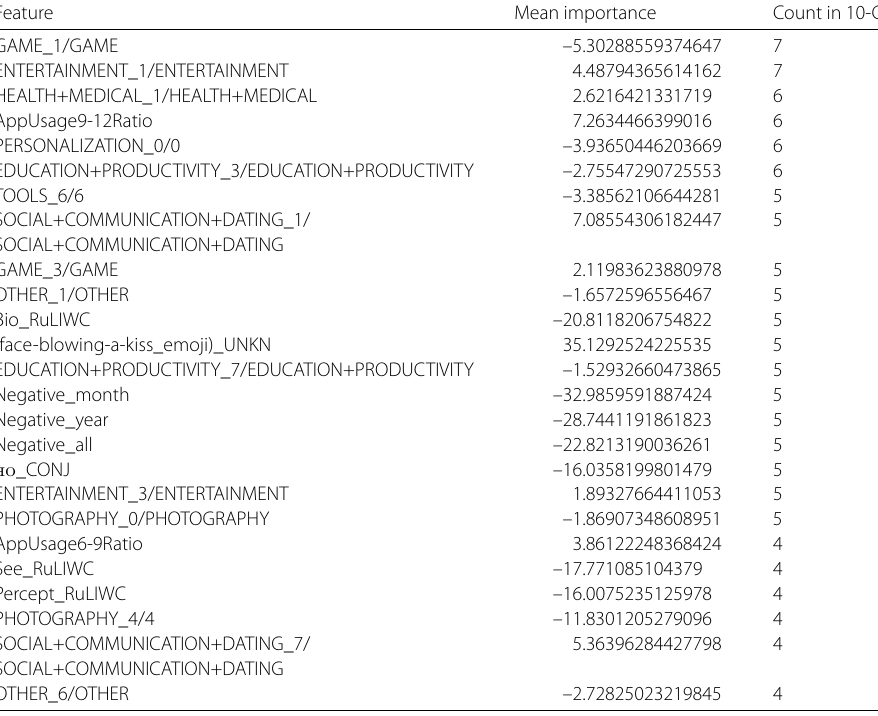
Table 23 Features significant in WHO-5 regression